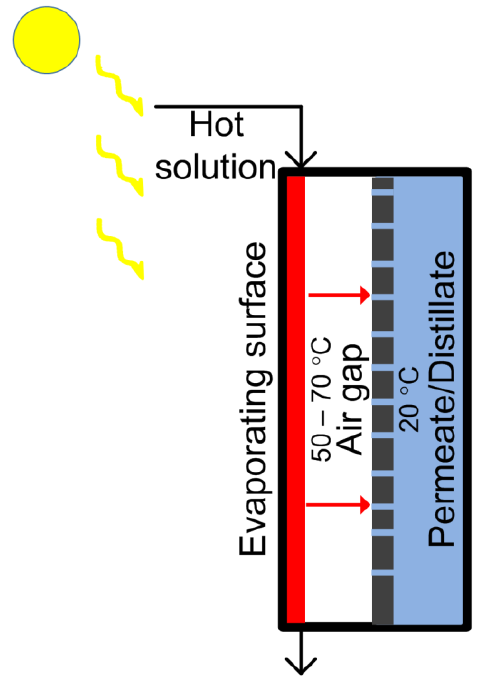
Figure 1. Film distillation with a porous (membrane) condensing surface (PMC). The initial solution is heated in an external heat exchanger and fed hot into the separation module [18].